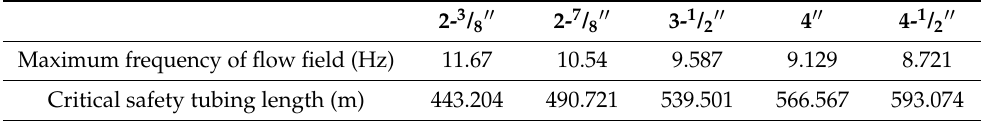
Table 2. Resonance occurrence depth of tubing with different